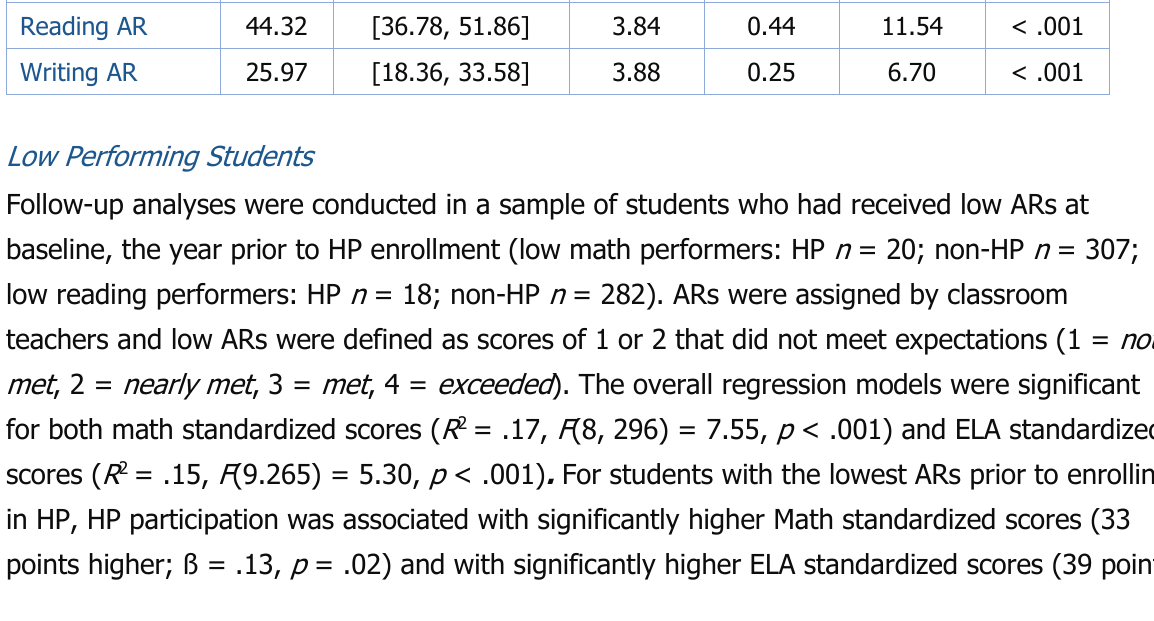
Table 6. Regression Coefficients of Model Predicting ELA SBAC Scores 2 Years After Harmony Enrollment Period Predictor